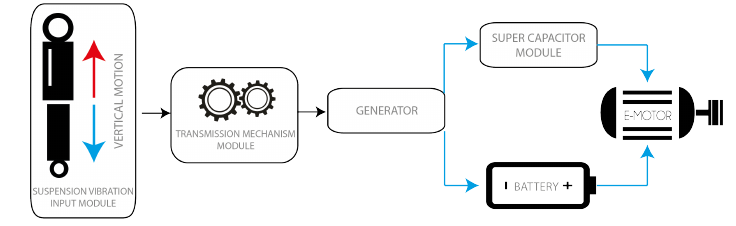
Figure 3. A diagram of the configuration of an